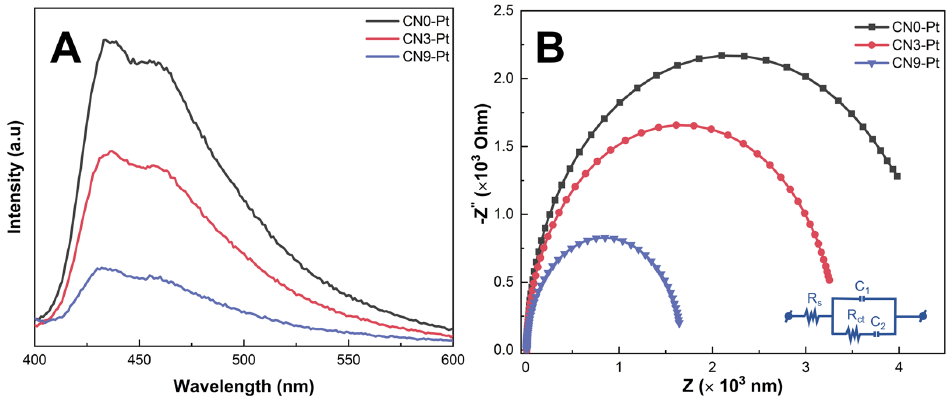
Figure 5. ( A ) PL spectra and ( B ) the EIS Nyquist plots of the CNx ‐ Pt photocatalysts.